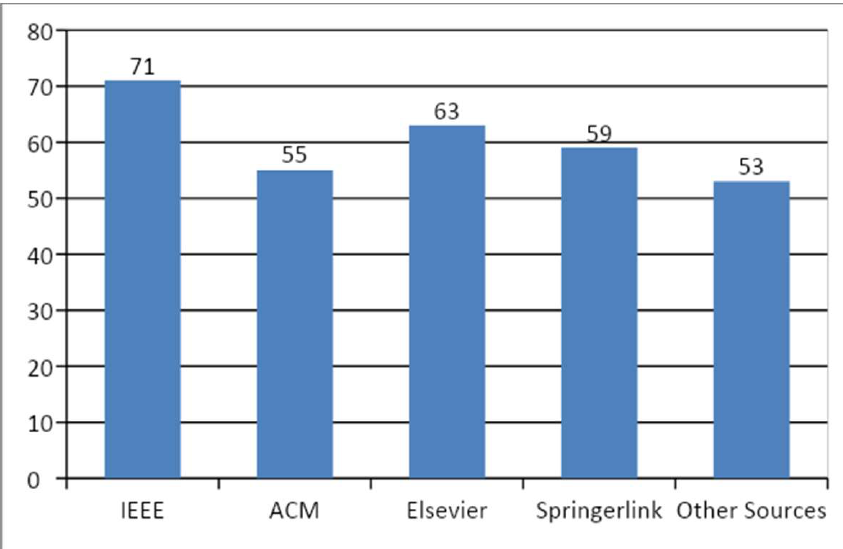
Figure 2. Papers and scientific databases .